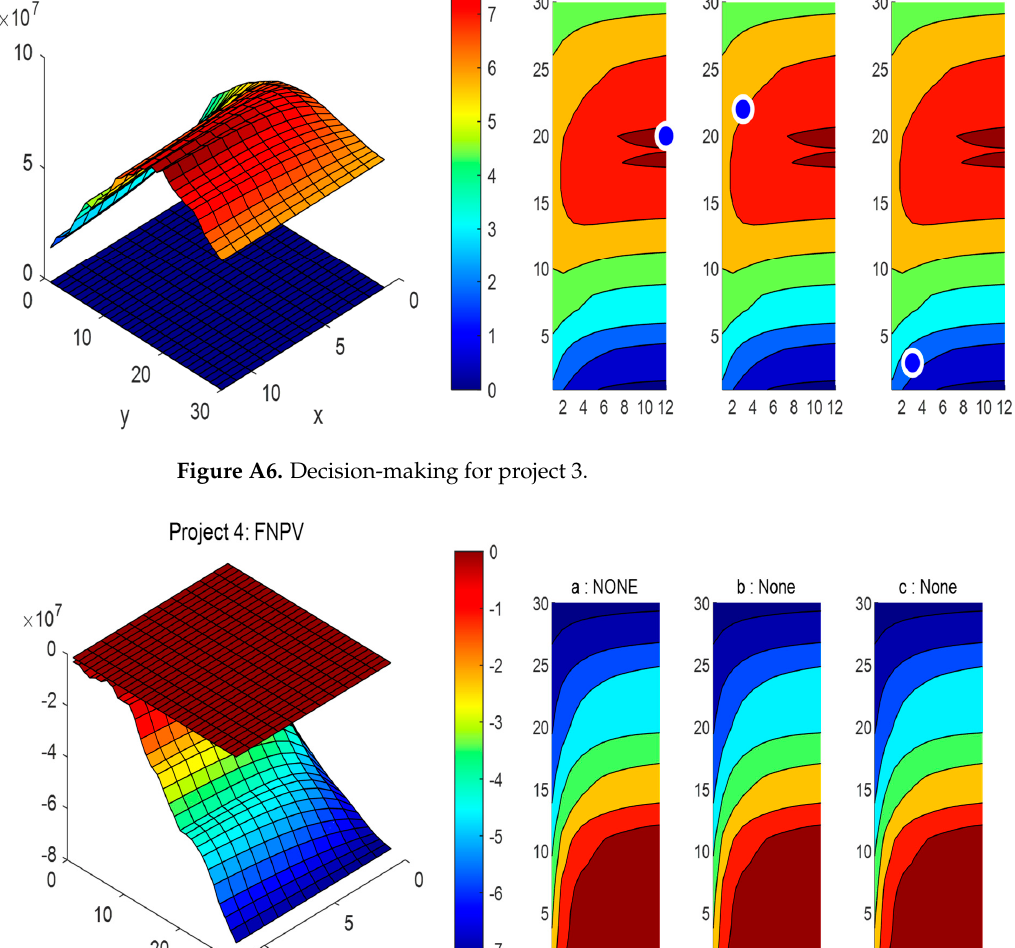
Figure A7. Decision − making for project 4.